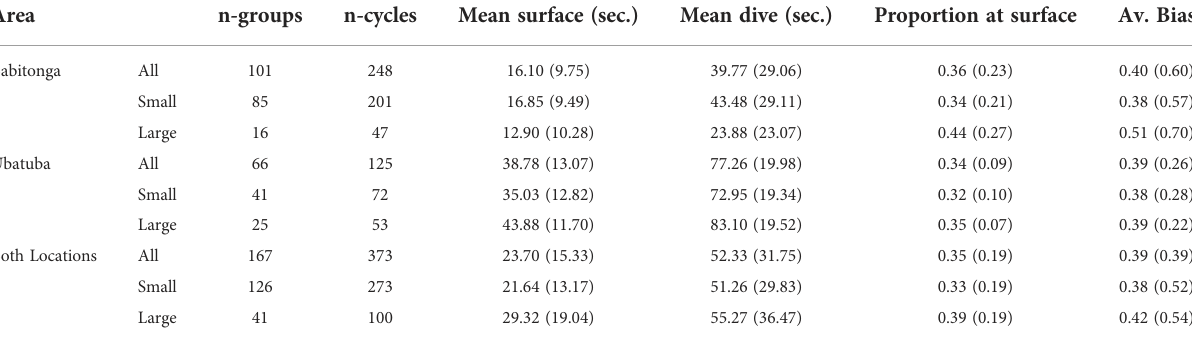
TABLE 9 Summary of franciscana groups surface-dive cycles data recorded during helicopter experiments in Babitonga Bay and Ubatuba, and estimated availability bias (Av. Bias).